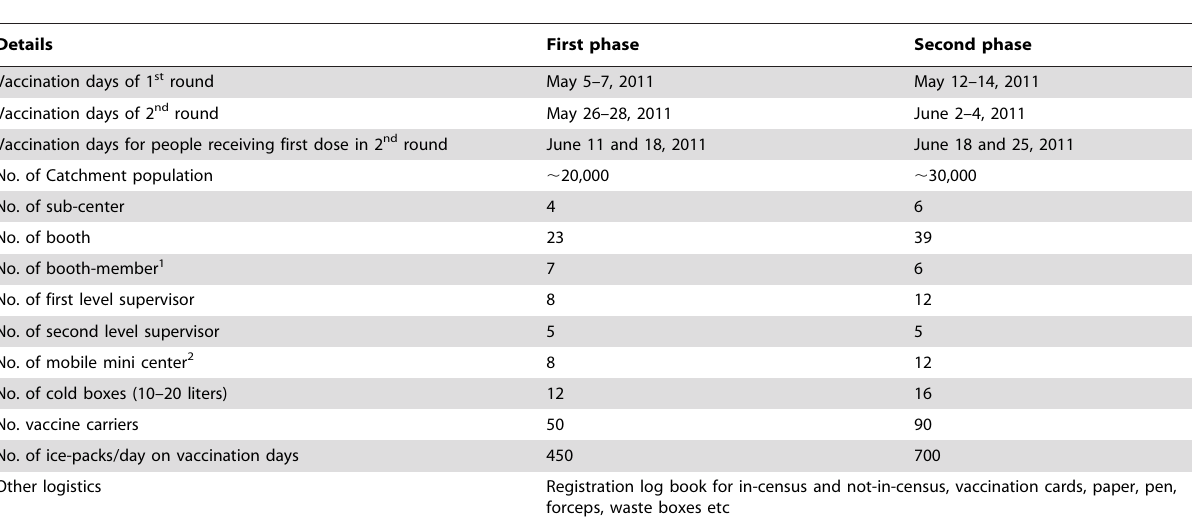
Table 2. Micro-planning for the cholera vaccination campaign in Satyabadi block in Odisha, India.